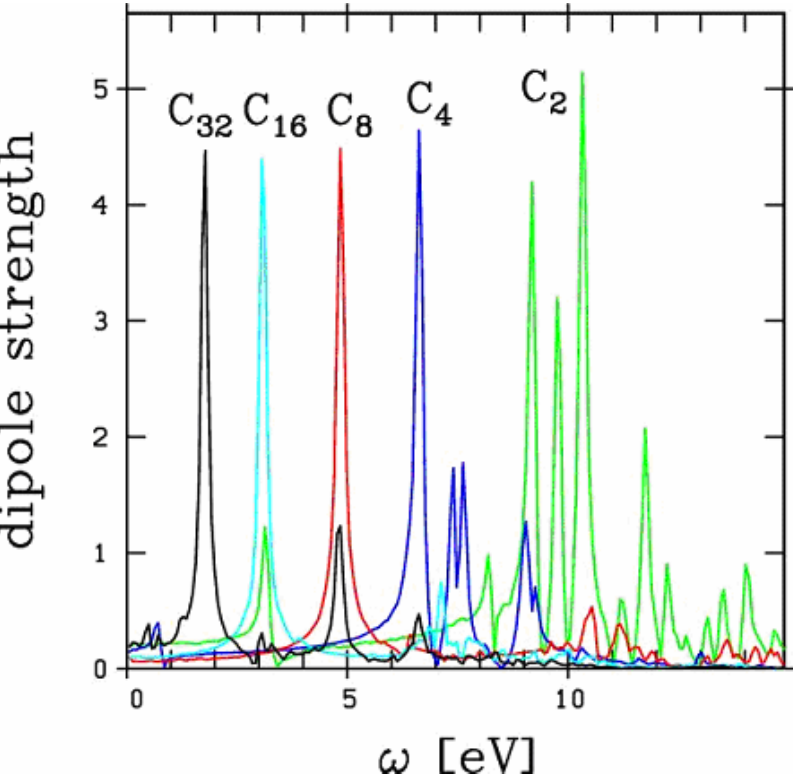
for n between 2 and 32. The n